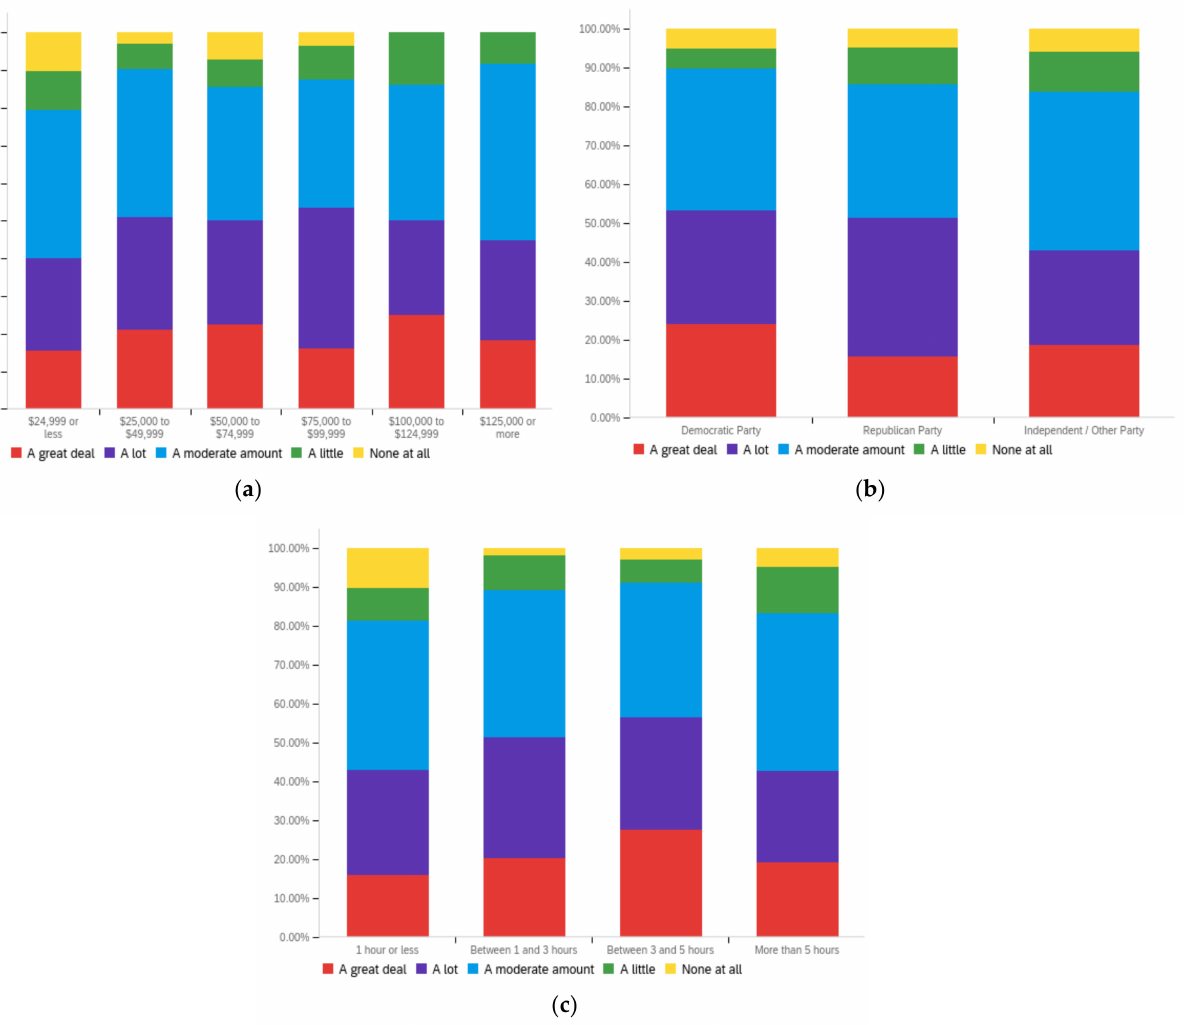
Figure A1. Article title—personal perception impact by: ( a ) income level (top left), ( b ) political affiliation (top right) and ( c ) online usage (bottom).